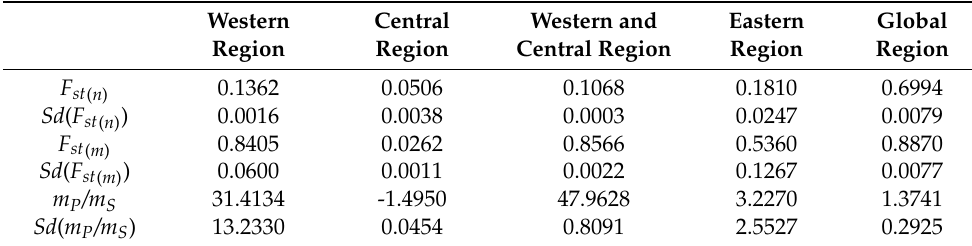
Table 4. Estimates of the relative rate of pollen to seed flow in local and global regions of T. ciliata